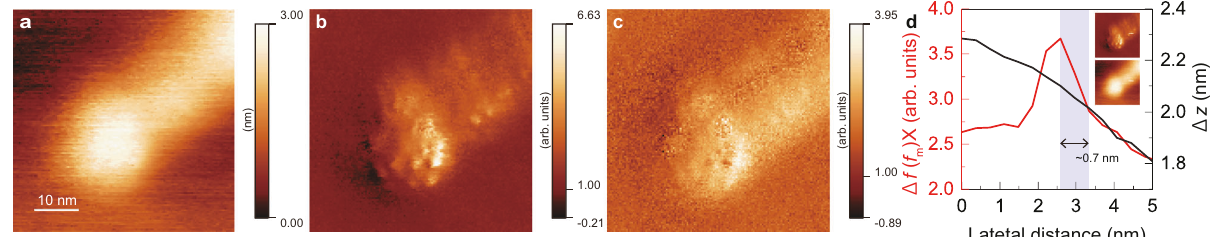
Fig. 2 PiFM imaging on one nanoellipsoid of a ZAIS QD. a AFM image of the ZAIS QD. b , c PiFM images of the ZAIS QD at 660 and 785 nm, respectively. d Δ f ( f m )X at 660 nm, and the pro fi le of Δ z in the middle of the ZAIS QD. This plot indicates that a spatial imaging resolution of ~0.7 nm was achieved. The positions at which the pro fi les were acquired are indicated in the insets. During imaging, the tip – sample distance was controlled via feedback control ( Δ f = − 20 Hz) with A = 10 nm.